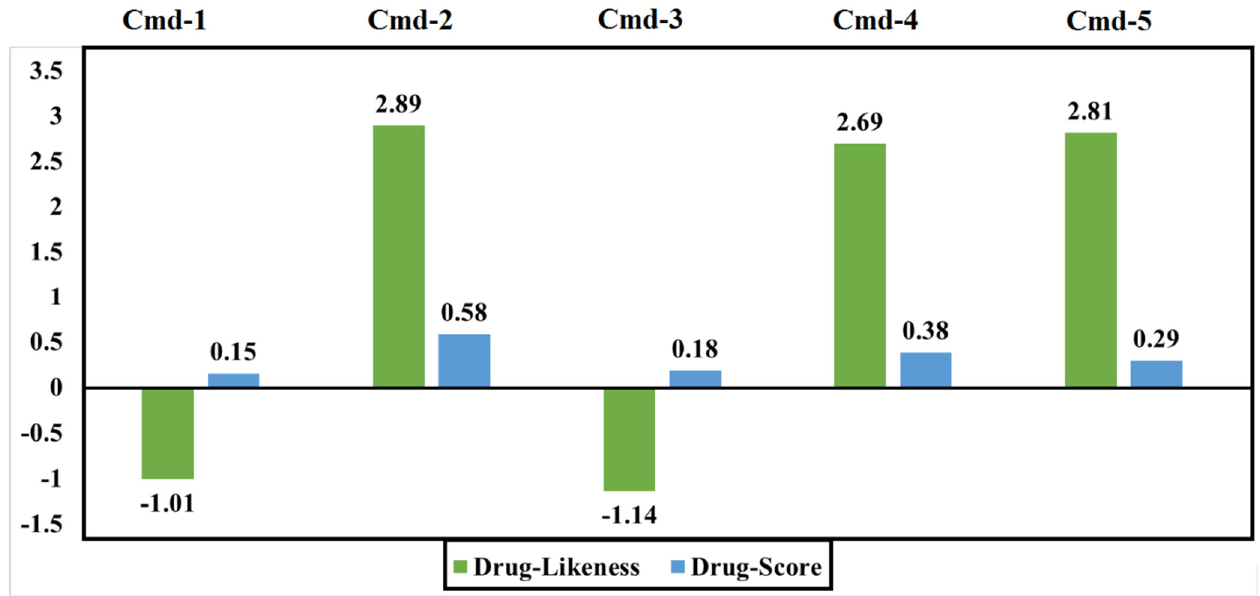
Figure 10. Predicted logS and cLogP values of the best identified Cmds.